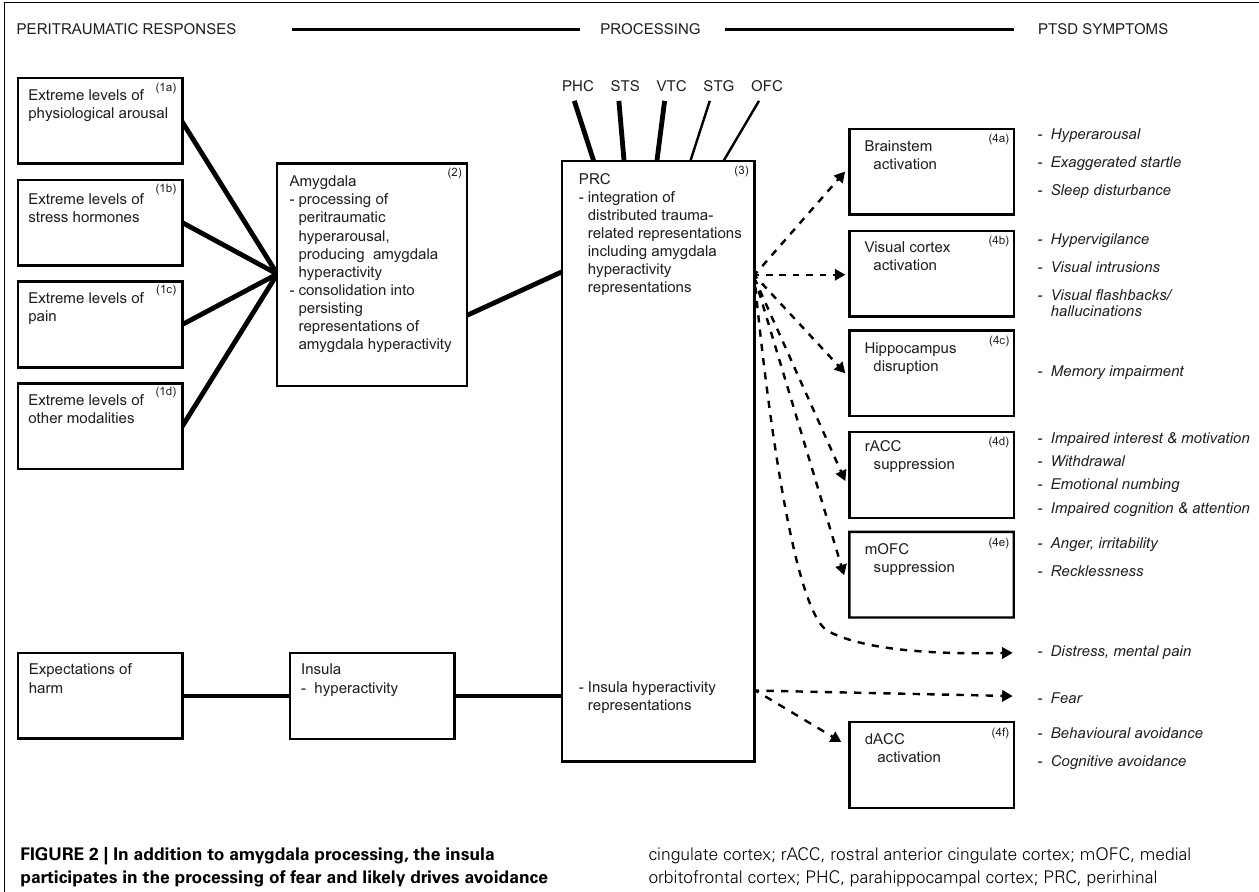
FIGURE 2 | In addition to amygdala processing, the insula participates in the processing of fear and likely drives avoidance symptoms .Together, these mechanisms account for some 80% of DSM-5 PTSD symptoms. Abbreviations: dACC, dorsal anterior